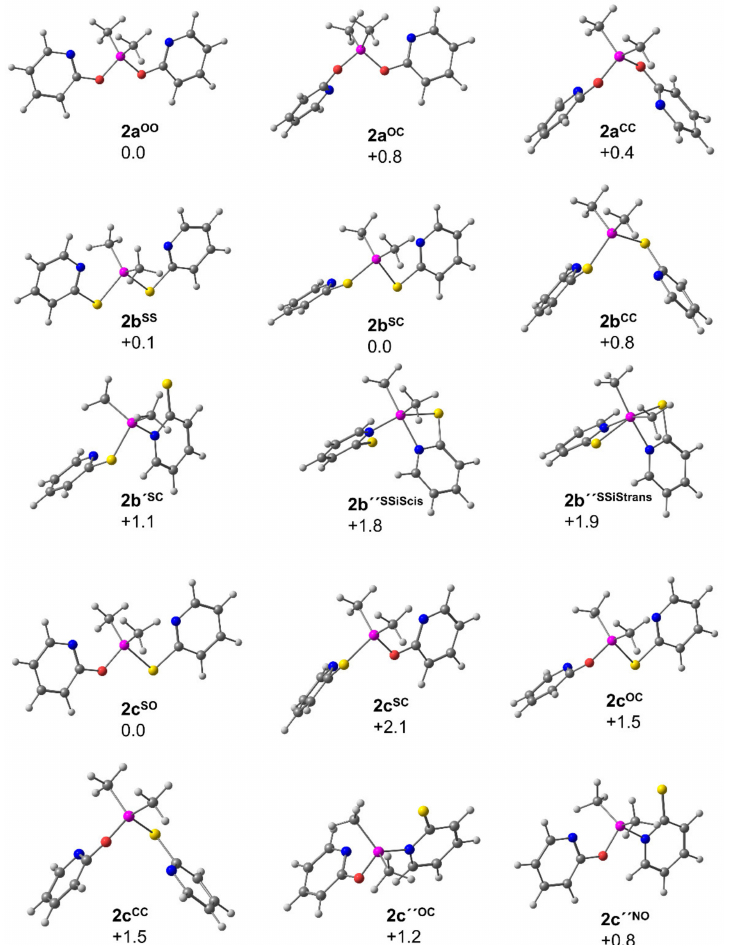
Figure 8. Relative Gibbs free energy values (in kcal · mol − 1 ) computed at the PBE0 D3BJ ZORA- def2-TZVPP level of theory for conformers of 2a , 2b and 2c and selected isomers with Si-N-bound substituent(s) 2b’ , 2b” and 2c” . For 2a , 2b and 2c , the superscript indices indicate the conformer in which the N atoms are capping tetrahedral faces trans to the superscript indexed atoms. Labels of the other isomers are based on related capping or on the relative S-Si-S arrangement within an octahedral coordination sphere (cf. Figures S27–S59 and Tables S9–S41 in the supporting